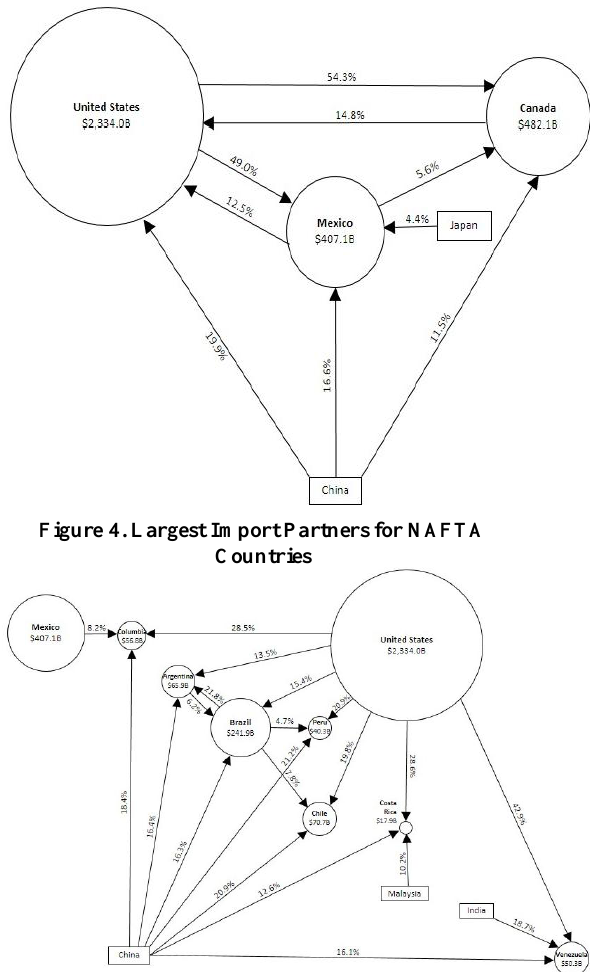
Figure 5. Largest Import Partners for Latin American